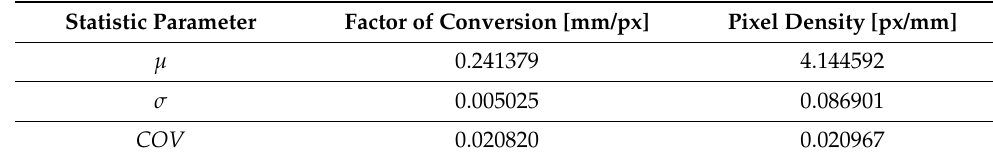
Table 5. Statistic parameters for the 23 tests